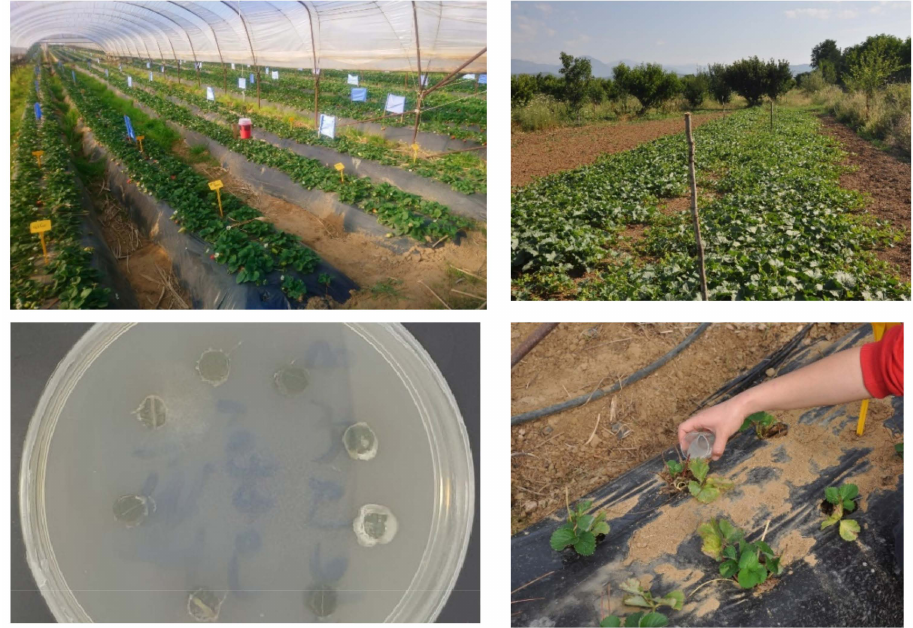
Figure 1. Experimental fields of strawberries ( up left ) and melons ( up right ), leaf pieces from treated plants in Petri dish showing B. bassiana hyphae growth ( down left ), watering experimental plant with 10 mL of conidial solution ( down right